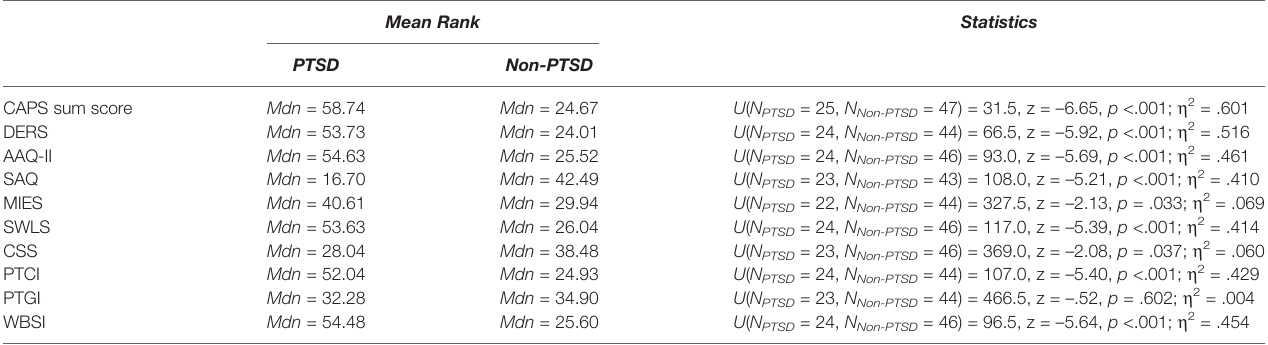
TABLE 5 | Results of Mann-Whitney-U-Tests regarding differences of mean ranks of measured questionnaires between service members with PTSD ( n = 25) and service members without PTSD ( n = 47; including treatment seekers).